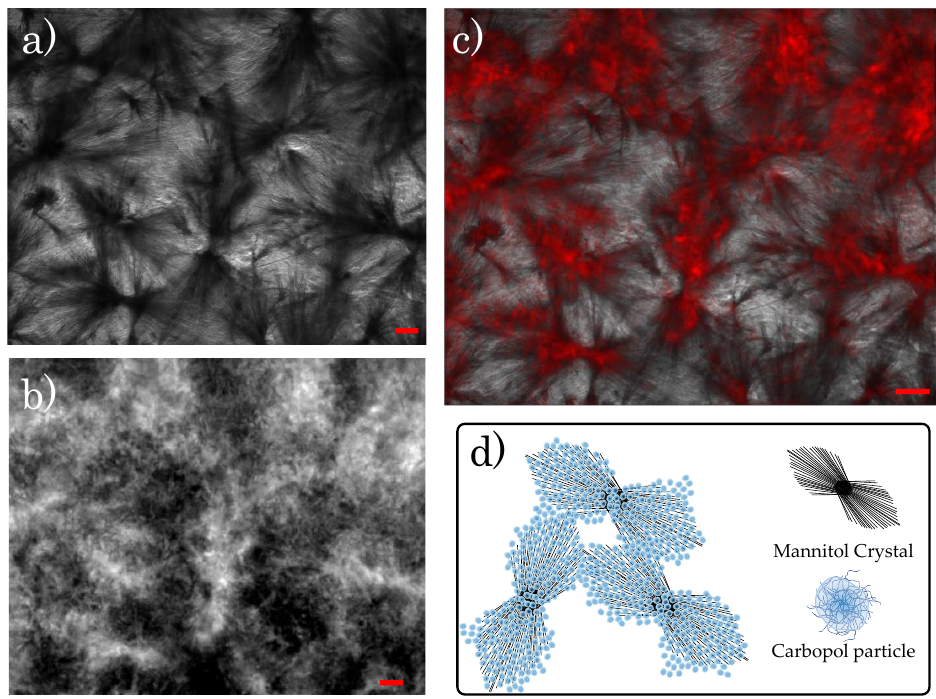
Figure 14. ( a ) Brightfield image of sample M2 at 0.7% wt of Carbopol. Mannitol crystals are the dark areas in the image; ( b ) corresponding fluorescence image of the same sample. In this case, the brighter areas are Carbopol molecules; ( c ) superposition of the two images in panel ( a , b ). The red colour of the Carbopol phase was artificially obtained to better highlight the superposition between Carbopol clusters and crystals; and, ( d ) cartoon of the structure observed. The scale bar, reported in red in panels ( a – c ) represents a dimension of 150 µ